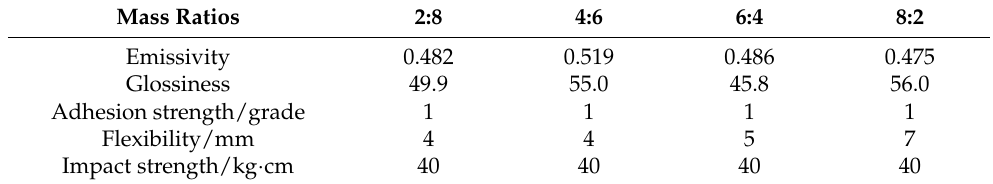
Table 1. Performance index of coatings under different mass ratios of epoxy resin to